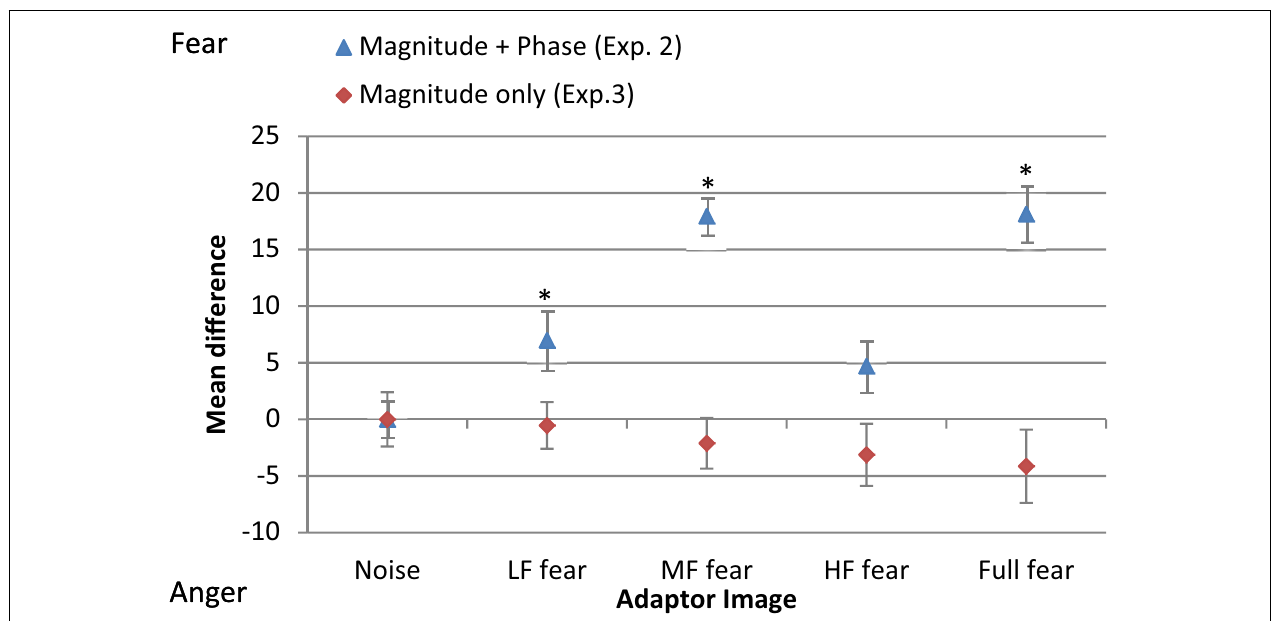
phase spectra (Experiment 2). Red diamonds represent results from adaptors with phase spectrum only (Experiment 3). Error bars show ± 1 standard error of the mean. Asterisks represent significant difference at p < 0.05 level from white noise